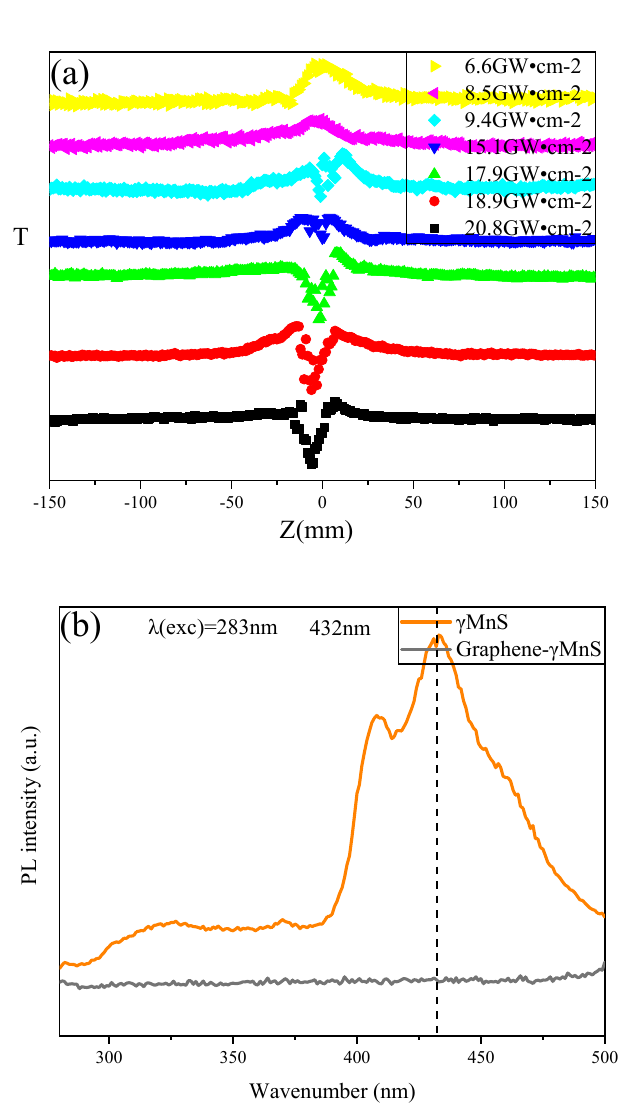
Figure 8. ( a ) OA Z-scan curves of graphene- γ MnS at 6.6 GW cm − 2 , 8.5 GW cm − 2 , 9.4 GW cm − 2 , 15.1 GW cm − 2 , 17.9 GW cm − 2 , 18.9 GW cm − 2 and 20.8 GW cm − 2 . ( b ) PL patterns of graphene- γ MnS and γ MnS.